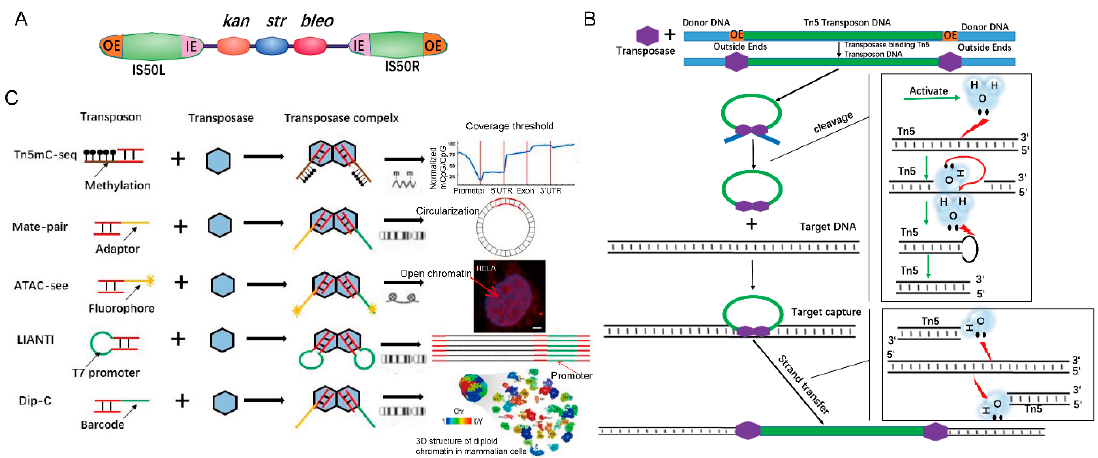
Figure 1. Tn5 transposon structure and transposition mechanism. ( A ). Tn5 transposon structure consisting of a core sequence that encodes three antibiotics and two inverted IS50 sequences. The outside ends (OEs) bind to Tn5 transposases. ( B ). Scheme of the Tn5 transposition mechanism [11]. ( C ). Tn5 adaptor modification is used in epigenetics, genomic structure, and chromatin visualization. Tn5mC-seq is used in research studies on DNA methylation. Mate-pair applied to the amplification of long DNA fragments. Assay for Transposase-Accessible Chromatin with high throughput sequencing (ATAC-Seq) is applied to open chromatin (scale bar 1:600). Linear Amplification via Transposon Insertion (LIANTI) is applied to genomic variation. Dip-C is used in reconstructing the 3D structure of the genome.